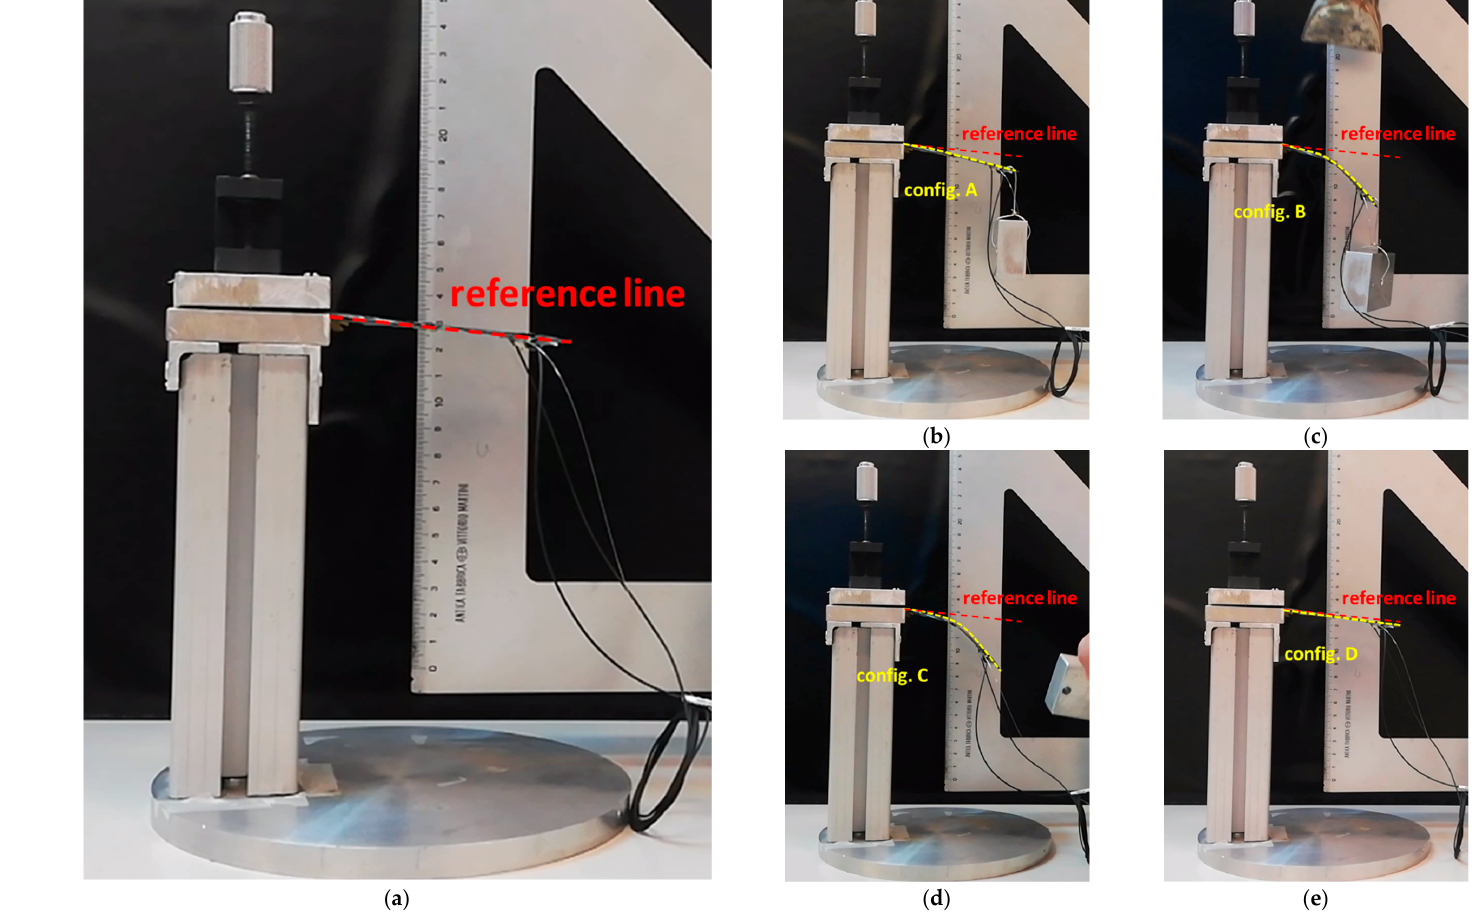
Figure 10. Different phases of the load–unload process: reference ( a ), loaded at low temperature ( b ), loaded at high temperature ( c ), unloaded after cooling ( d ), recovery ( e ).